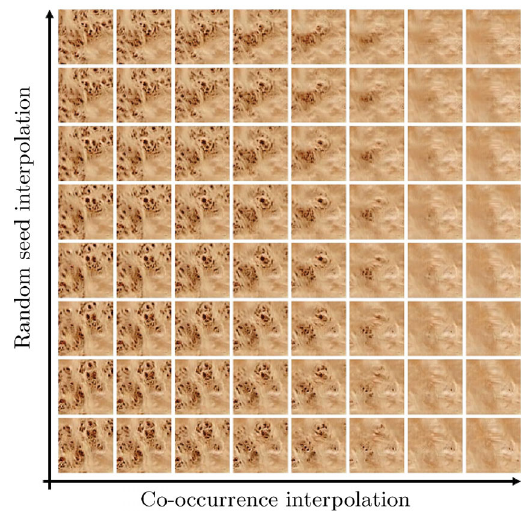
Fig. 4 Our technique synthesizes textures given a co-occurrence matrix and a random seed vector. Above we illustrate textures generated from interpolating between two co-occurrence vectors (across the columns) and two random seed vectors (across the rows).